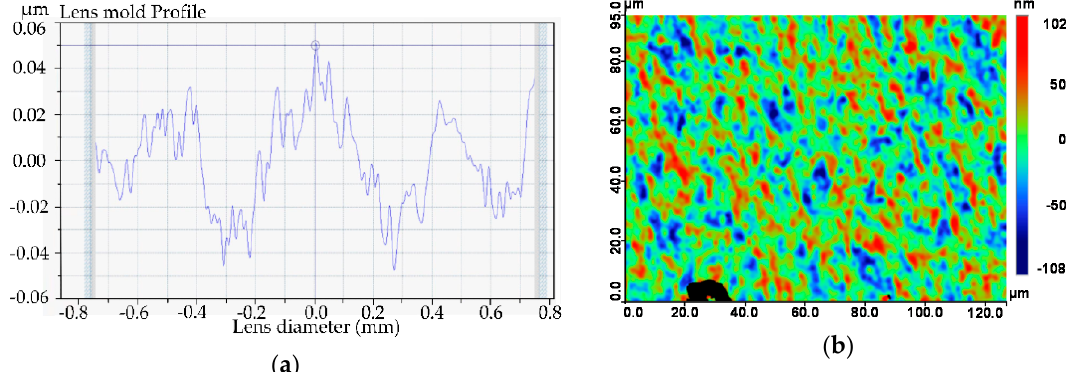
Figure 8. ( a ) Stylus profile measurement results of the lenslet mold with nanostructures (peak-to-valley (PV) error = 0.0985 μ m). ( b ) Surface roughness of the MLA mold with nanostructures (Sa = 15.683 nm).